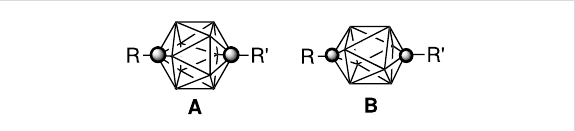
Figure 1: The molecular structures of 1,12-dicarba- closo - dodecaborane (12-vertex p -carborane, A ) and 1,10-dicarba- closo - decaborane (10-vertex p -carborane, B ). Each vertex corresponds to a BH fragment and the sphere represents a carbon atom.